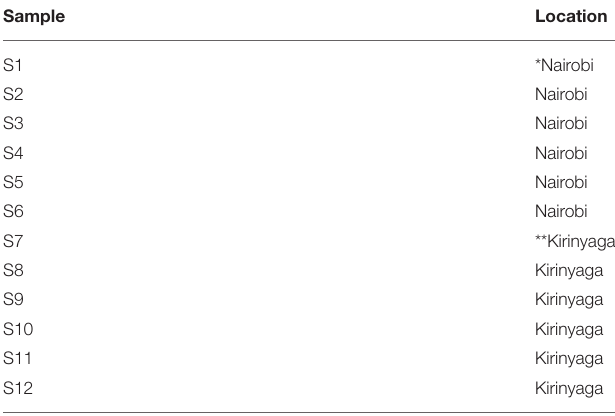
TABLE 1 | Sample information.